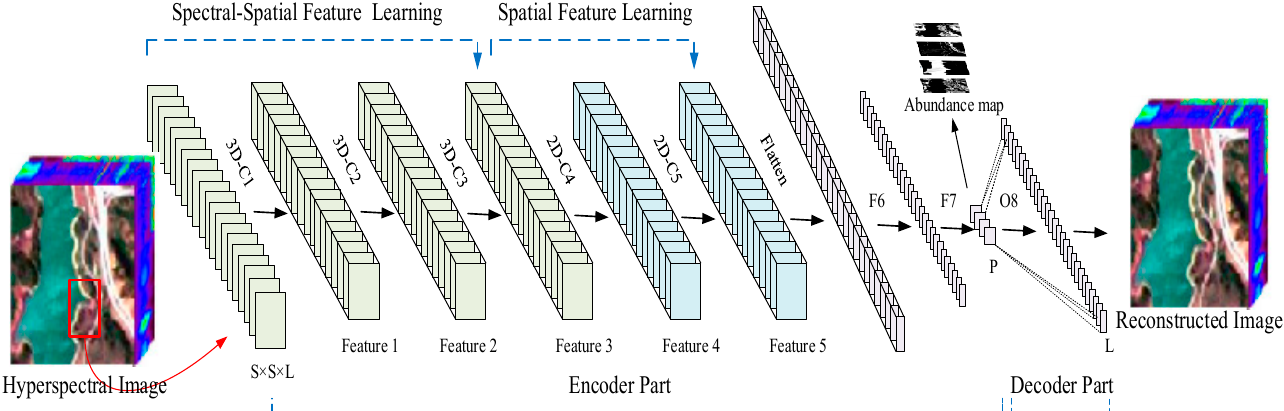
Figure 2. Flowchart of the proposed DHCAE Approach for robust hyperspectral unmixing (HSU). In the DHCAE framework, the dimensions of the 3D convolution kernels are as fol- lows: 3D_C1 = 8 × 3 × 3 × 9 × 1 (i.e., 𝐾 (cid:2869)(cid:2869) = 𝐾 (cid:2870)(cid:2869) = 3, and 𝐾 (cid:2871)(cid:2869) = 9), 3D_C2 = 16 × 3 × 3 × 7 × 1 (i.e., 𝐾 (cid:2869)(cid:2870) = 𝐾 (cid:2870)(cid:2870) = 3, and 𝐾 (cid:2871)(cid:2870) = 7) and 3D_C3 = 32 × 3 × 3 × 5 × 1 (i.e., 𝐾 (cid:2869)(cid:2871) = 𝐾 (cid:2870)(cid:2871) = 3, and 𝐾 (cid:2871)(cid:2871) = 5). Whereas dimensions of the 2D convolution kernels are 2D_C4 = 64 × 3 × 3 × 5760 (i.e., K 4 = K 4 = 3) and 2D_C5 = 128 × 3 × 3 × 128 (i.e., K 5 2 1